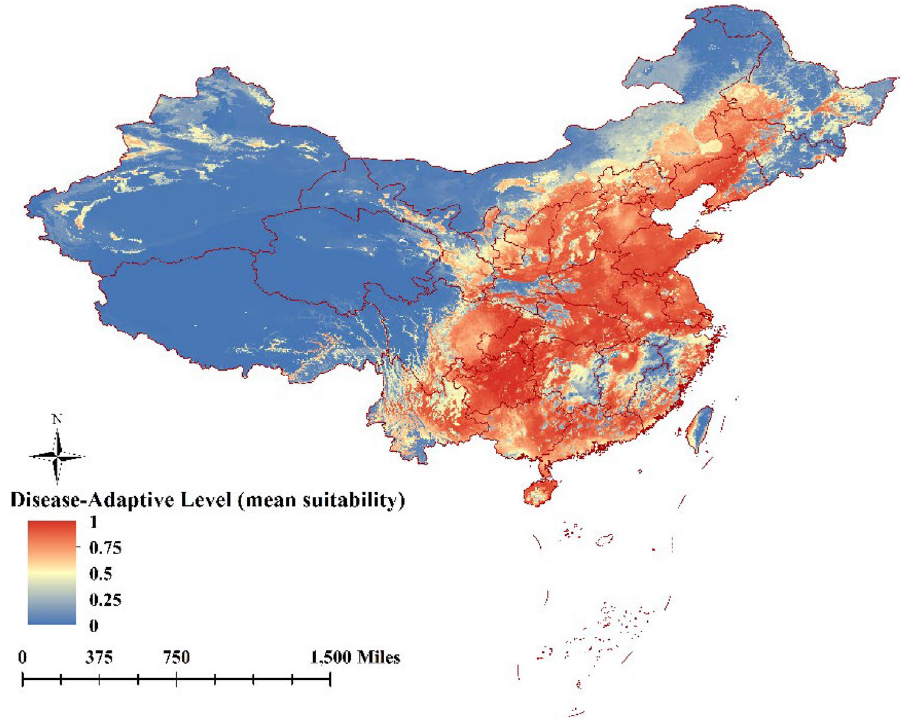
Figure 2. The disease-adaptive level of the ensemble model was expressed as the mean suitable. (The map is made by ArcGIS10.2 https:// www. esri. com/ and R 4.1.3 software https:// mirro rs. bfsu. edu. cn/ CRAN/).